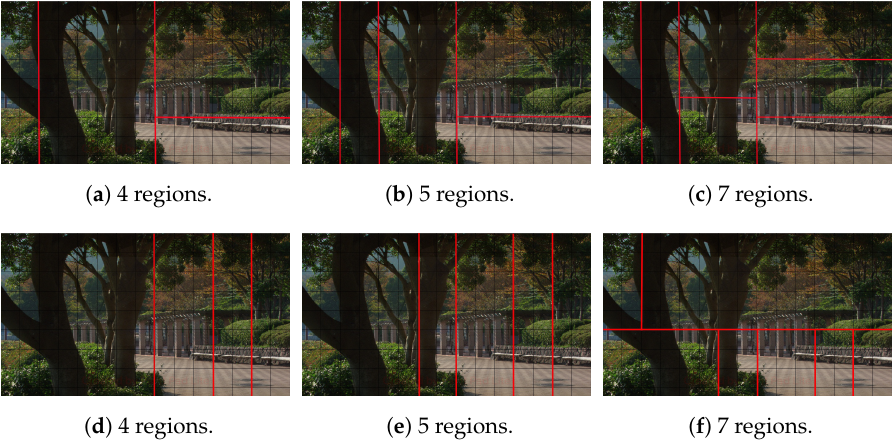
Figure 9. Parkscene video sequence: ( a – c ) Serial Region Growing, ( d – f ) Concurrent Region Growing.